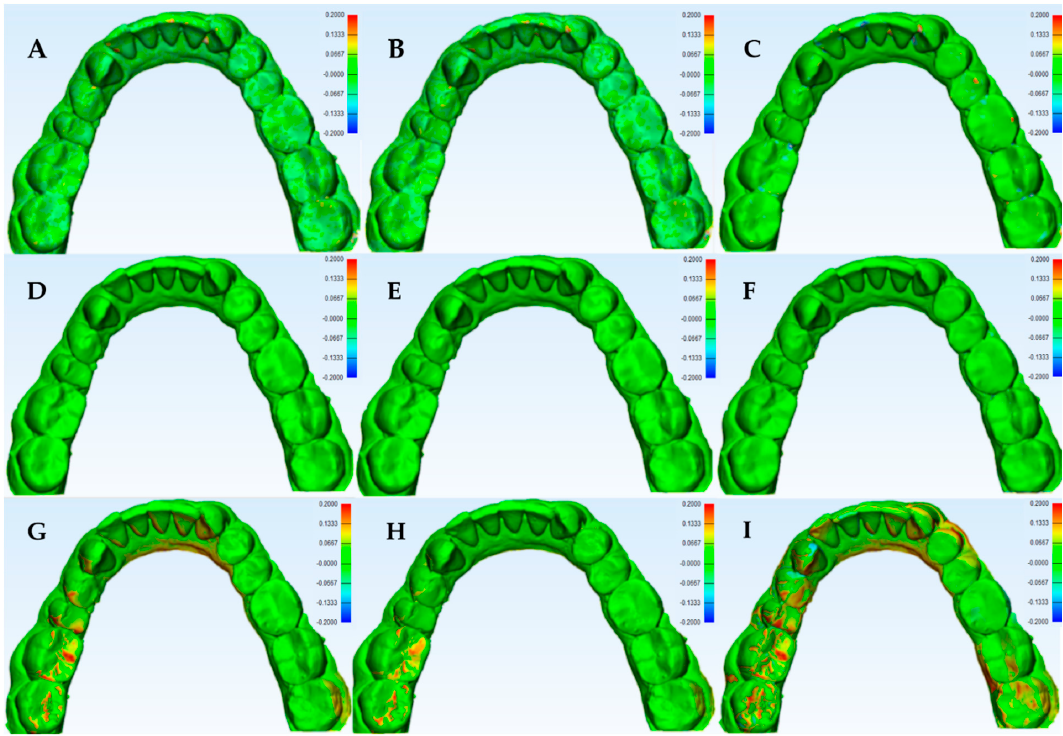
Figure 3. 3D color histogram for precision analysis of the tested scanners in one model. ( A – C ) are 1st vs. 2nd, 2nd vs. 3rd, 1st vs. 3rd scans. The first row ( A – C ) for OS, ( D – F ) for CBCT and ( G – I ) for the IOS.